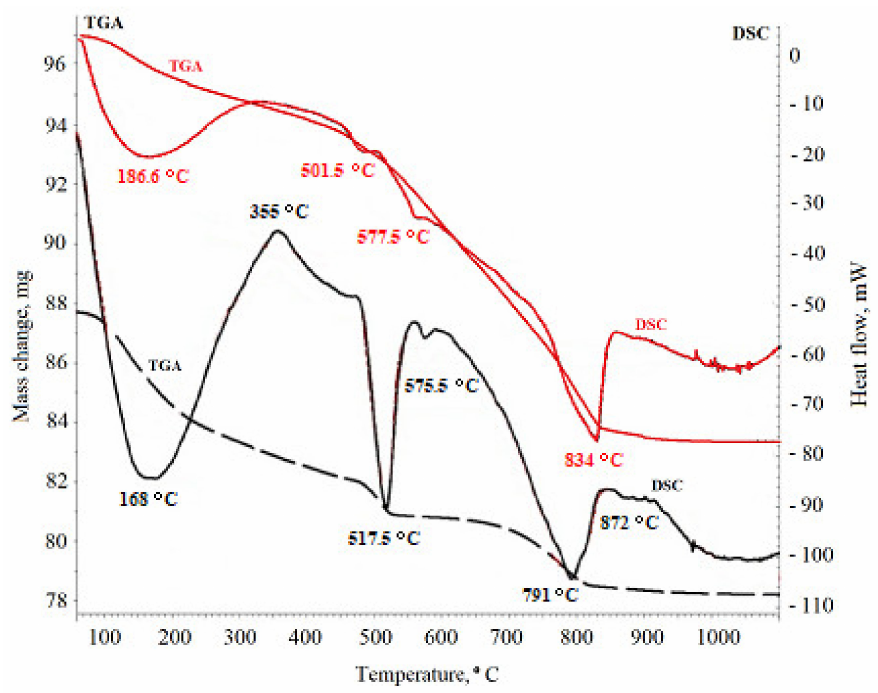
Figure 13. Differential scanning calorimetry and thermogravimetric analysis patterns of samples with silica fume and nanotubes cured for 28 days under normal conditions (black curves: sample without additives; red curves: sample modified with 0.005% MWCNTs and 3%